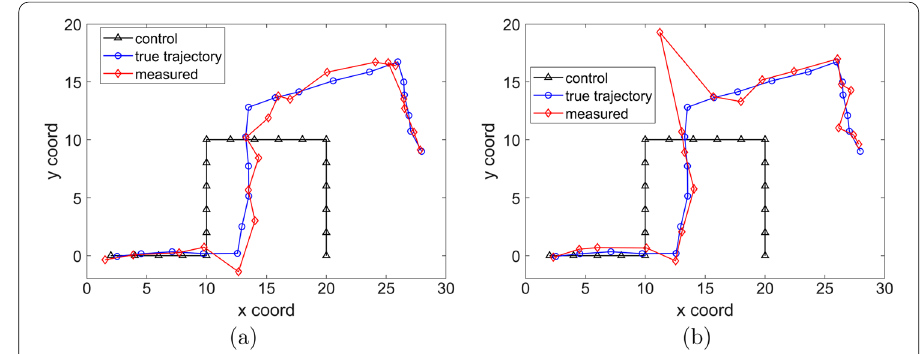
Fig. 3 Mobile robot simulation for n = 20 poses showing control ( v t = 0, w t = 0 ), true trajectories ( w t = 0 ) and measured trajectories a with no outliers b with